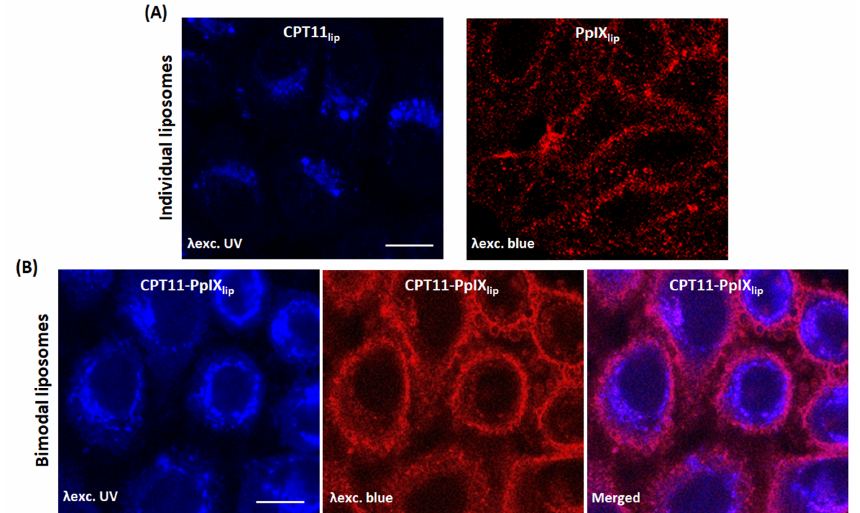
Figure 4. Subcellular location of CPT11 and PpIX on HeLa cells. ( A ) Representative images by confocal microscopy of drug location into cells incubated with the individual (TOP) or ( B ) bimodal liposomes (BOTTOM). Scale bar: 10 µ